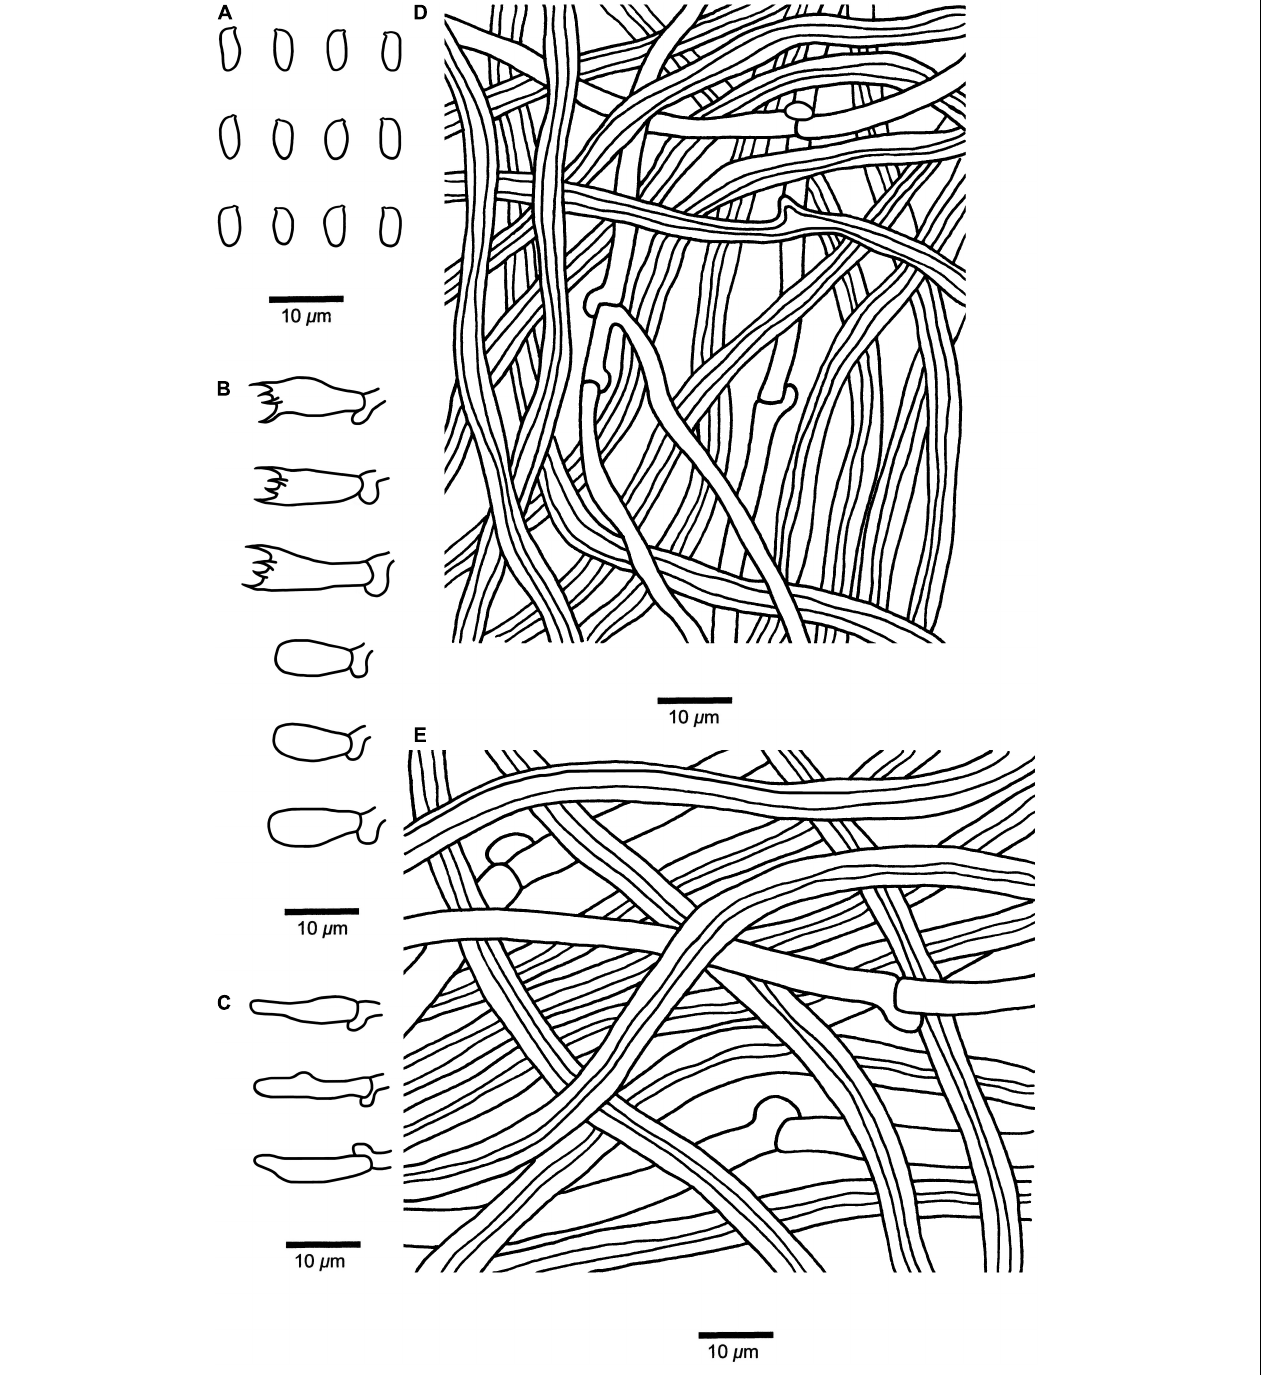
FIGURE 5 | Microscopic structures of Fomitopsis submeliae (Holotype, Dai 18559 ). (A) Basidiospores. (B) Basidia and basidioles. (C) Cystidioles. (D) Hyphae from trama. (E) Hyphae from context. Drawings by: Shun Liu.